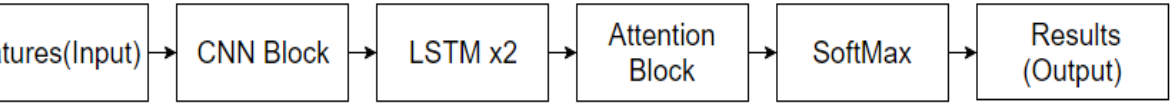
Figure 4. The overall process from input to output.